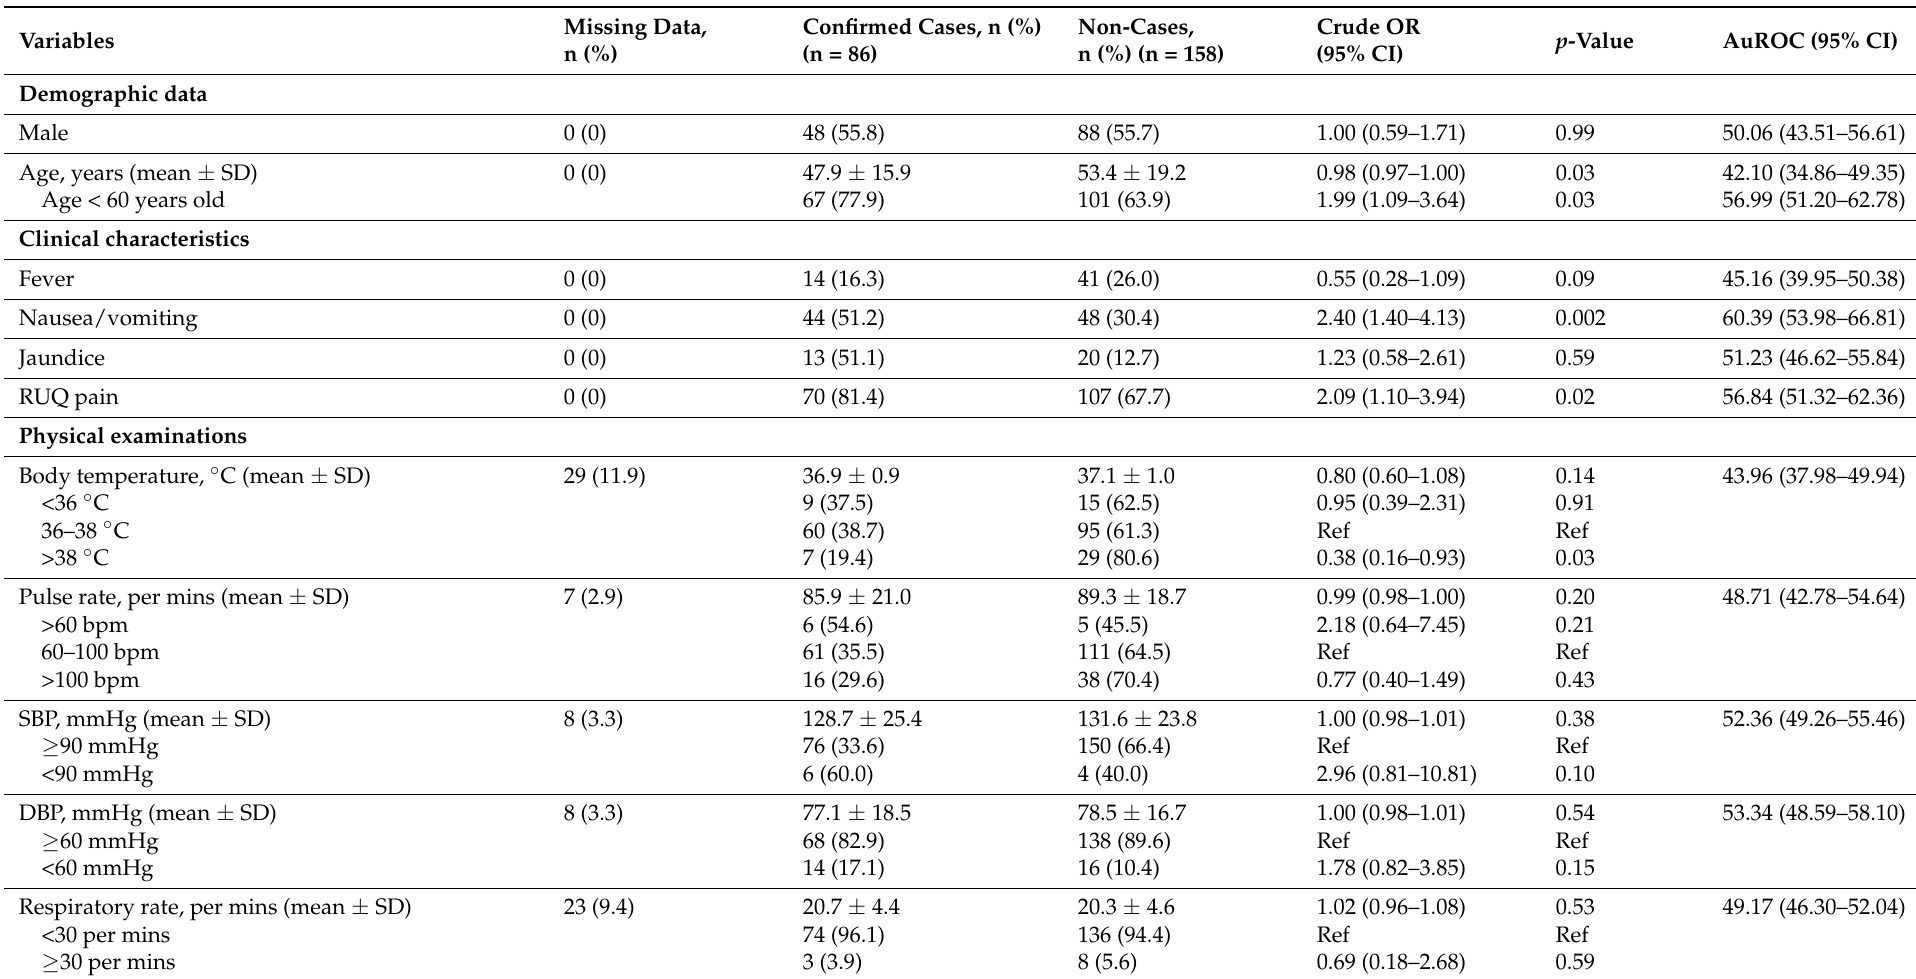
Table 1. Baseline demographic variables, clinical characteristics, physical examinations, and initial laboratory investigations of the derivation cohort; comparison of confirmed cases and non-cases of acute